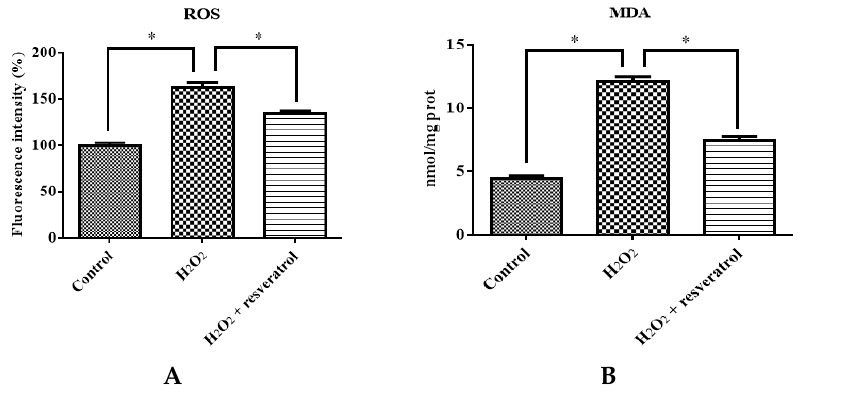
rate ( p < 0.05) (Figure 6E,F).